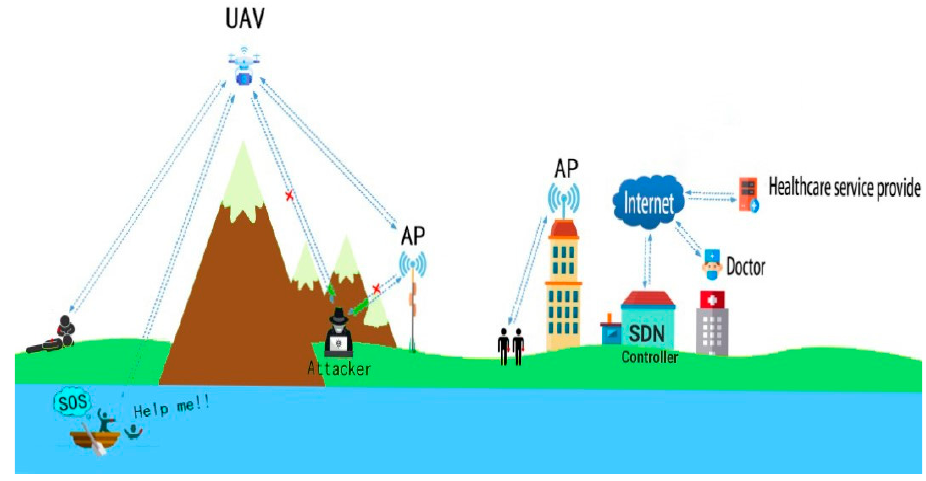
Figure 1. Application scenario of UAV.